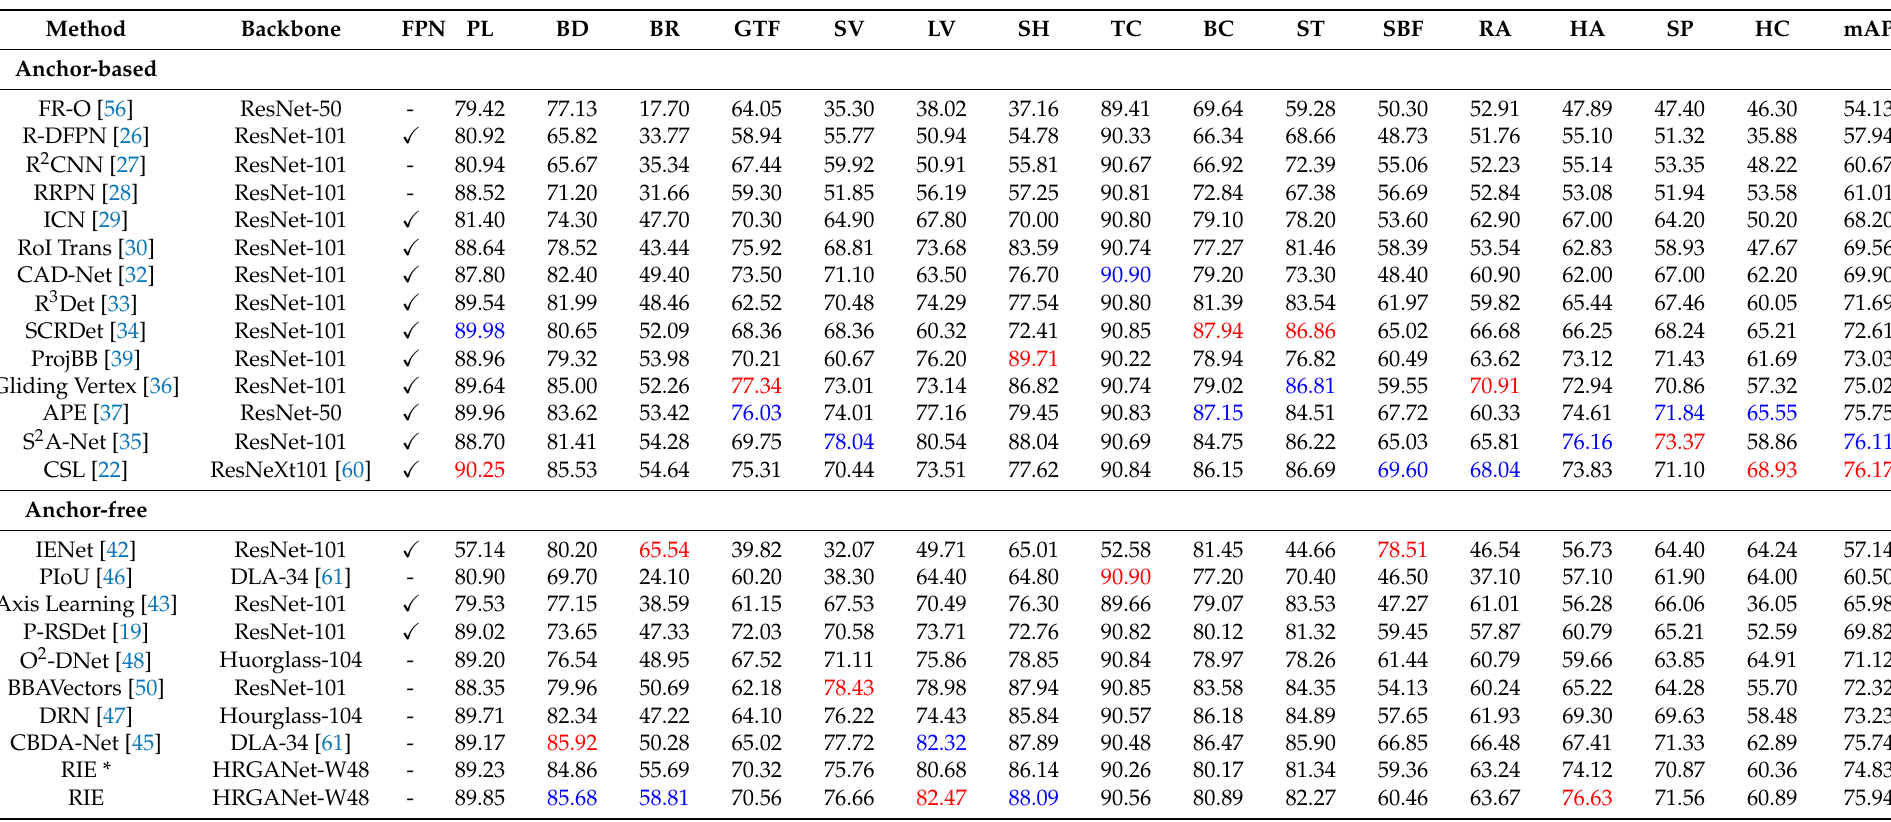
Table 2. Comparison with state-of-the-art methods of oriented object detection in RSIs on the DOTA dataset. We set the IoU threshold to 0.5 when calculating the AP.